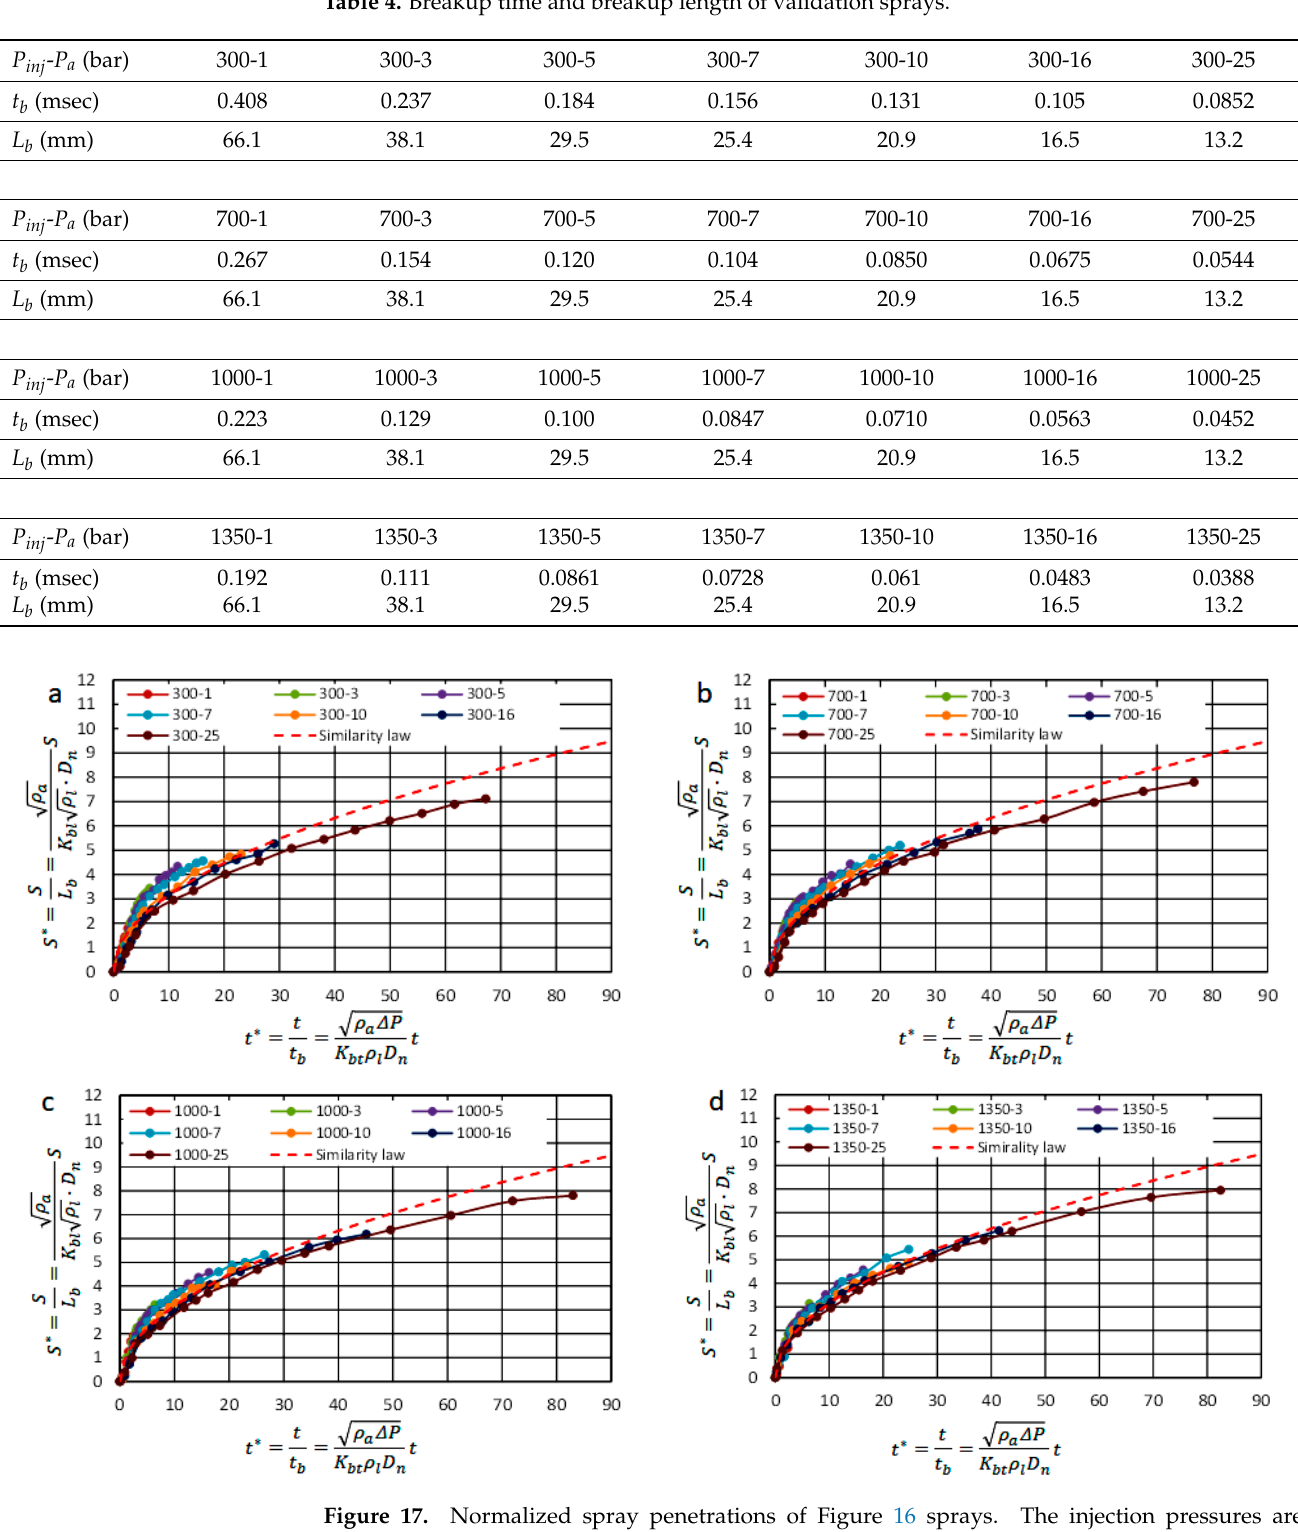
Figure 17. Normalized spray penetrations of Figure 16 sprays. The injection pressures are: ( a ) P i = 300 bar, ( b ) P i = 700 bar, ( c ) P i = 1000 bar, ( d ) P i = 1350 bar. The dashed line corresponds penetration of similarity law equation with 𝑆 ∗ = √𝑡 ∗ .